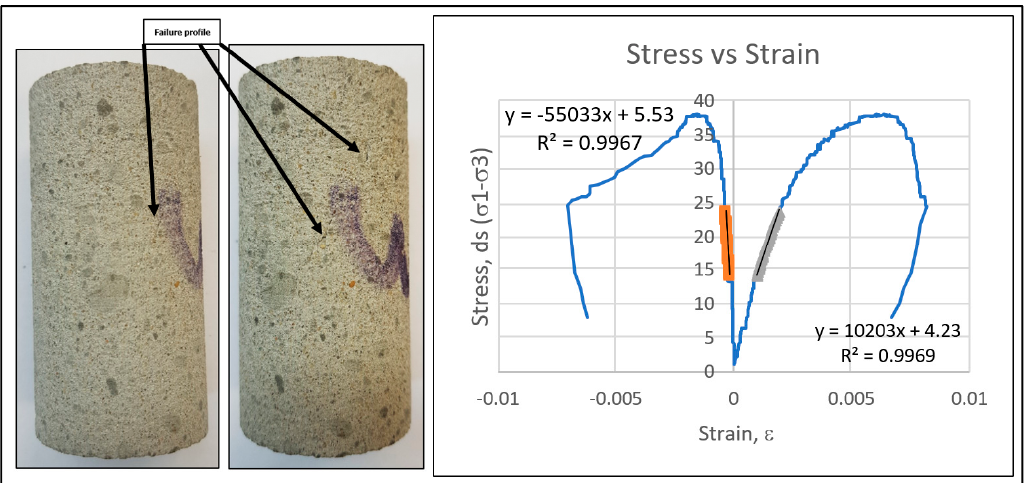
Figure 5. Uniaxial compressive strength test results for saturated samples. Table 1. Uniaxial compressive strength and Young’s modulus comparison of dry and saturated samples. Figure 4. Uniaxial compressive strength test results for dry samples. Figure 4. Uniaxial compressive strength test results for dry samples. Materials 2019 , 12 , x FOR PEER REVIEW